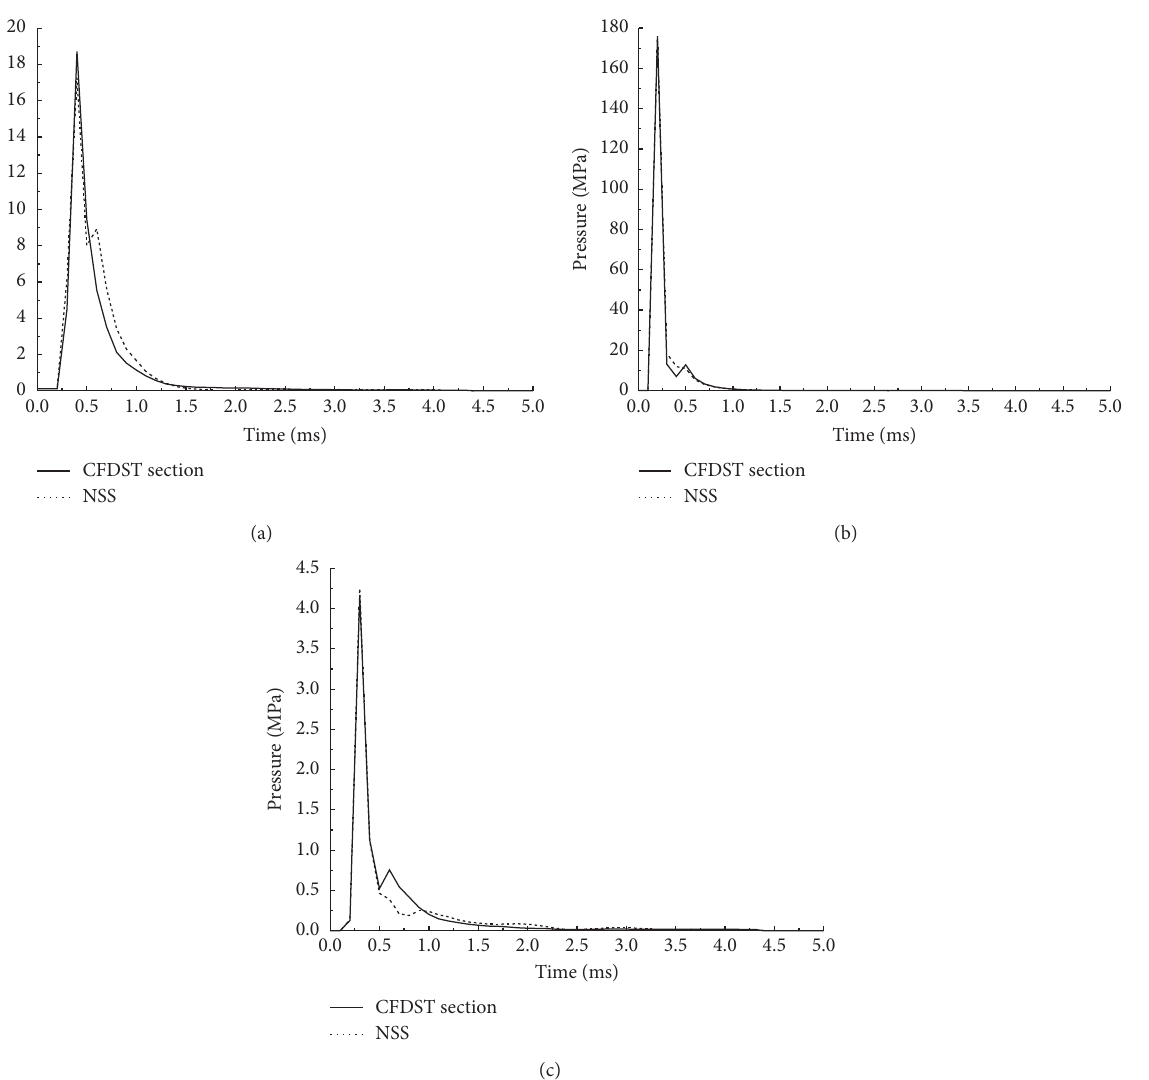
Figure 16: Pressure-time curves at different positions on the column surface facing the explosive. (a) Bottom of column. (b) Middle of column. (c) Top of